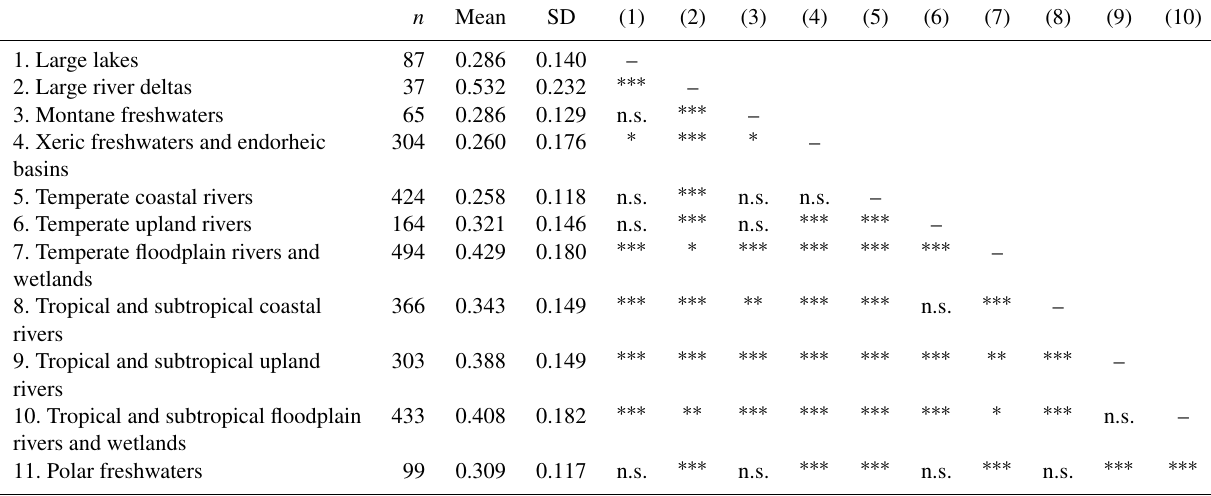
Table A6. Summary statistics and pairwise comparisons of how MAI-500 (the model agreement index of GFPLAIN, GAR-500, and JRC- 500) varies with the freshwater major habitat types that spatially dominate the river basin. A Kruskal–Wallis test showed that there is a significant difference in model agreement between freshwater habitat types ( H( 10 ) = 478, p < 0 . 001). The pairwise comparisons, for detecting significant differences between the habitat types, have been conducted using the Wilcoxon rank-sum test with continuity